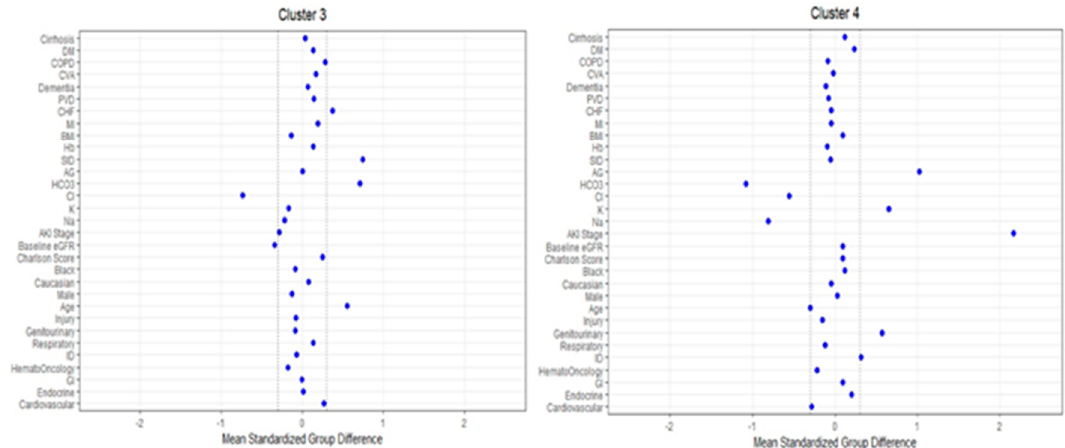
Figure 3. The standardized differences across the four clusters for each baseline parameter. The x-axis is the standardized difference value, and the y axis shows baseline parameters. The dashed vertical lines represent the standardized differences cutoffs of < − 0.3 or >0.3. Abbreviations: AKI, acute kidney injury; DM, diabetes mellitus; COPD, chronic obstructive pulmonary disease; CVA, cerebrovascular accident; PVD, peripheral vascular disease; CHF, congestive heart failure; MI, myocardial infarction; BMI, body mass index; Hb, hemoglobin; SID, strong ion difference; AG, anion gap; ESKD, end-stage kidney disease; HCO3, bicarbonate; Cl, chloride; K, potassium; Na, sodium; GFR, glomerular filtration rate; RS, respiratory system; ID, infectious disease; GI, gastrointestinal.